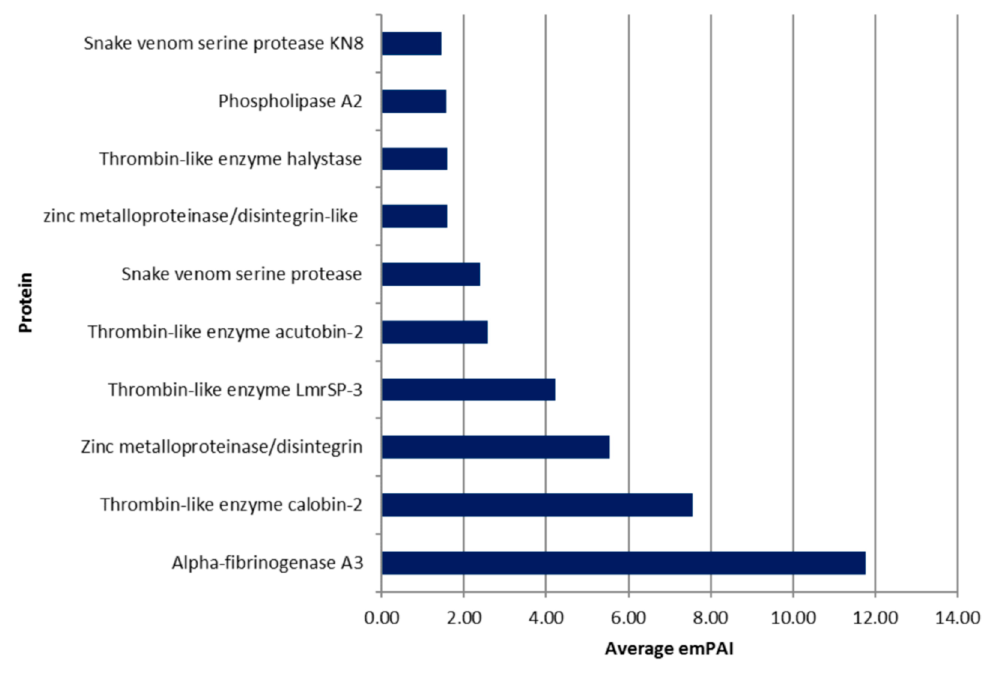
Figure 6. The top-ten most abundant proteins in Protobothrops kelomohy venom (PKV).